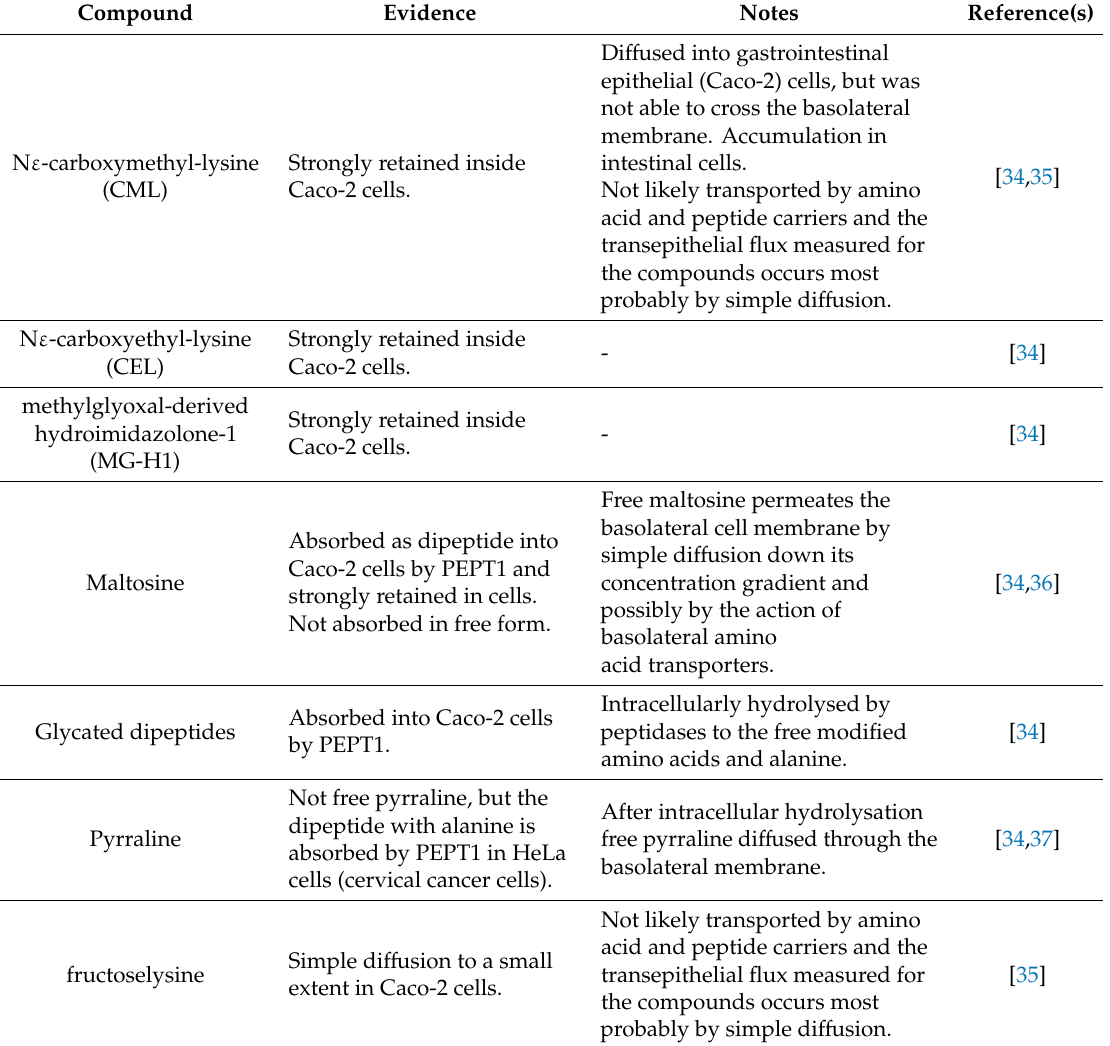
Table 1. Summary of uptake of individual dAGEs in the in vitro